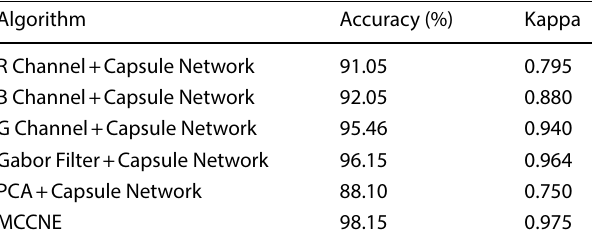
Table 2 Comparison of results for ensemble and individual classi-